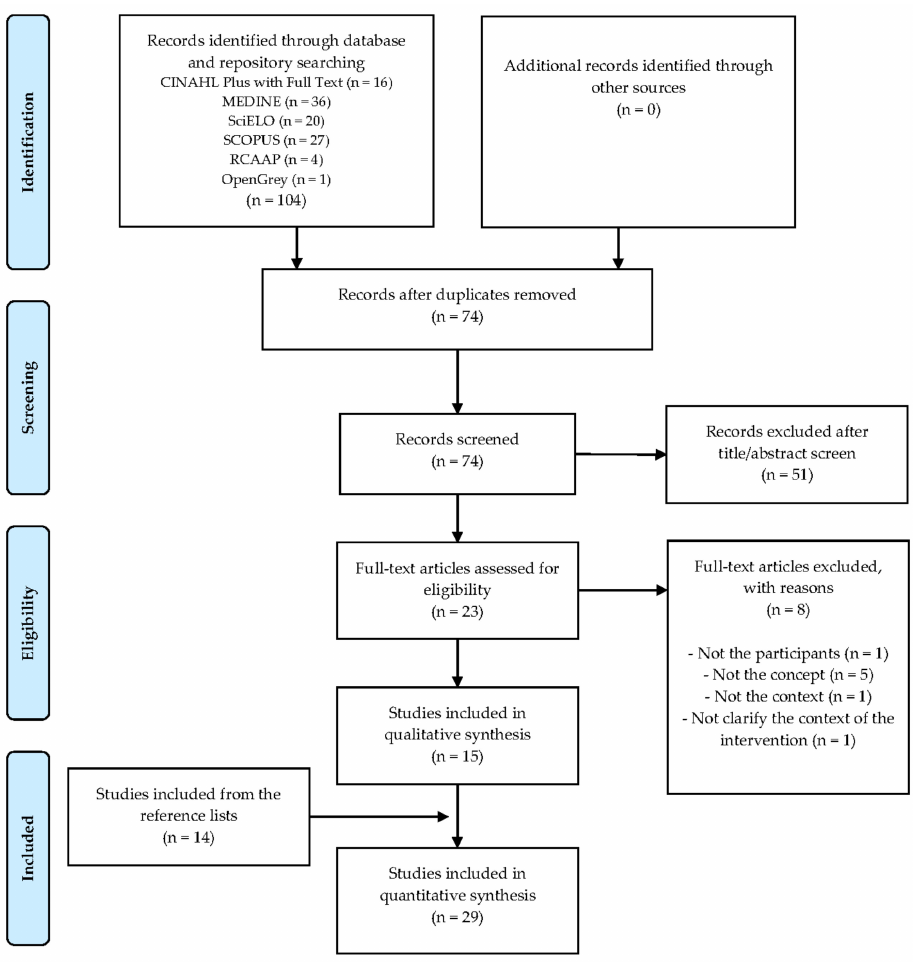
Figure 1. Article search and selection process—PRISMA